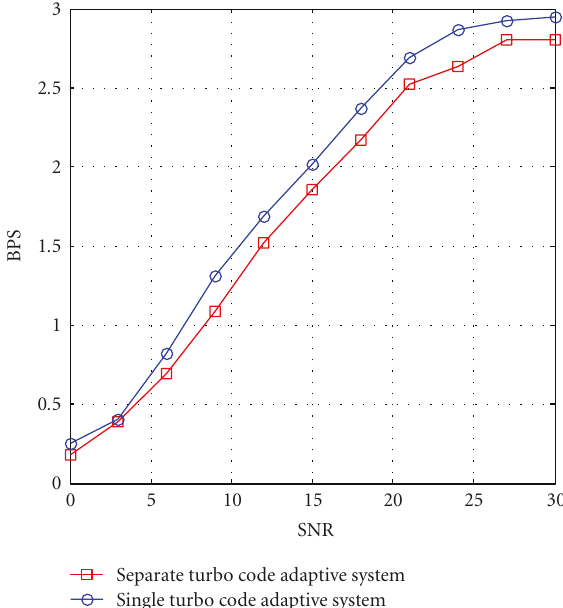
Figure 8: Throughput of separate turbo code system and one turbo code